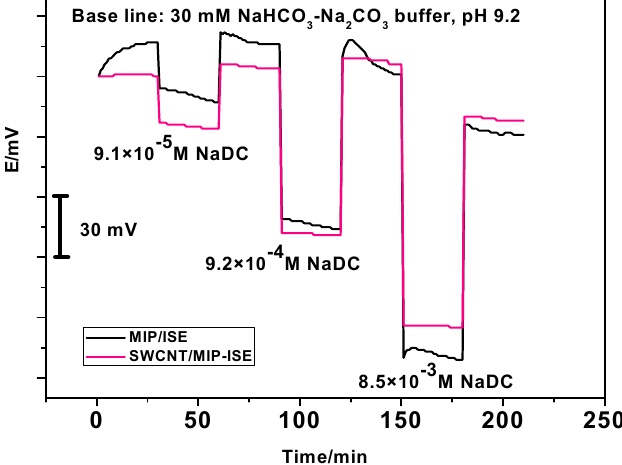
Figure 5. Life-span of the proposed deoxycholate membrane based sensor.